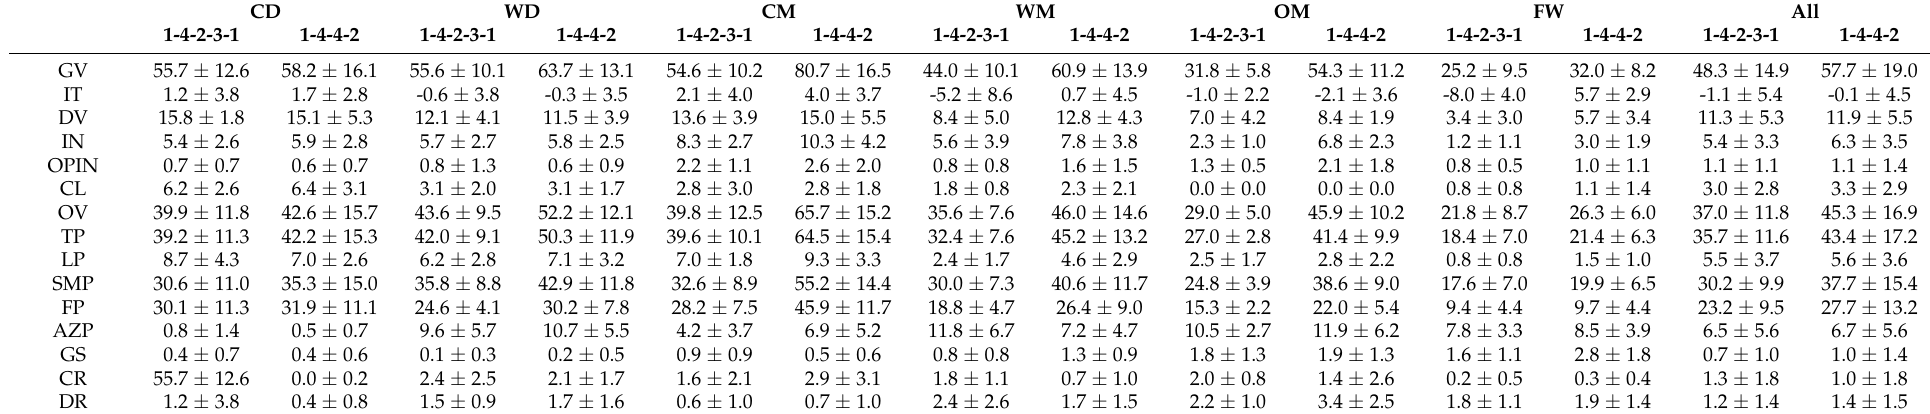
Table 4. Descriptive of the technical-tactical actions (mean ± SD) encountered by soccer players for each playing position and for all players using the 1-4-2-3-1 and 1-4-4-2 diamond playing